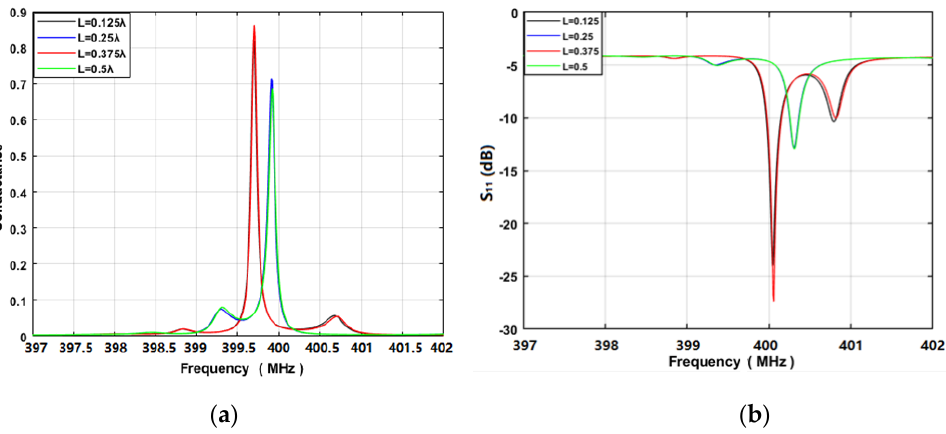
Figure 12. COM simulation on sensing device: ( a ) conductance, ( b ) S 11 .